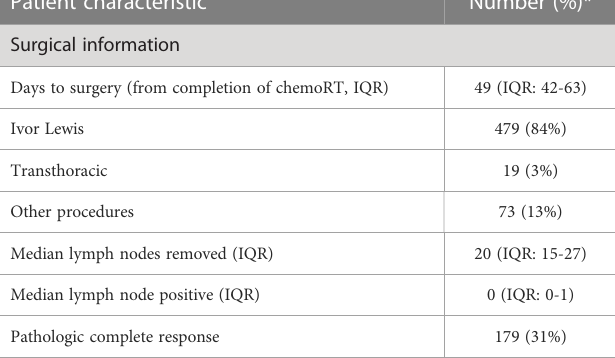
both a continuous and categorical variable, and OS were assessed using Cox proportional hazards analysis. The CPTTB risk score was generated and used to predict CPTTB as both a continuous and discretized outcome using RPA. Secondary endpoints included LOS and DR60. Disease-free survival considered the time to recurrence or death (from any cause) while disease-speci fi c survival only included death if it was secondary to disease (as opposed to another cause). DR60 was analyzed as a binary event using logistic regression, and LOS as a continuous outcome using linear regression. Statistical signi fi cance was